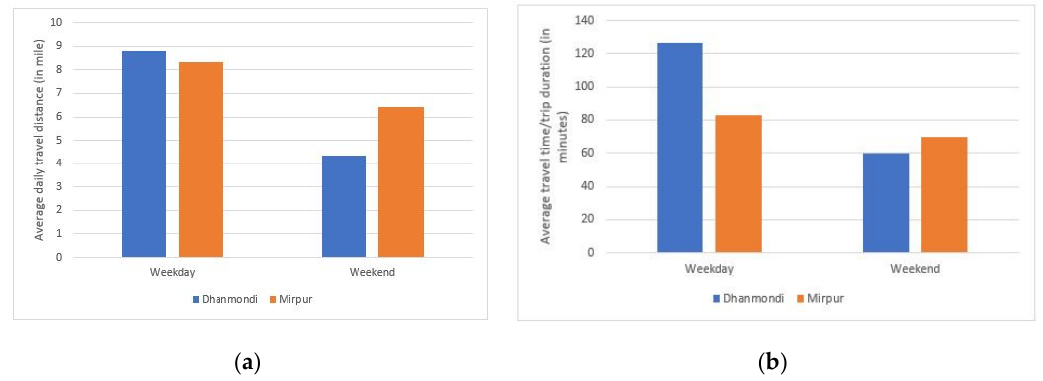
Figure 4. Trip characteristics of respondents in weekdays and weekend from both study sub-areas. ( a ) Average daily travel distance and ( b ) travel time/trip duration.